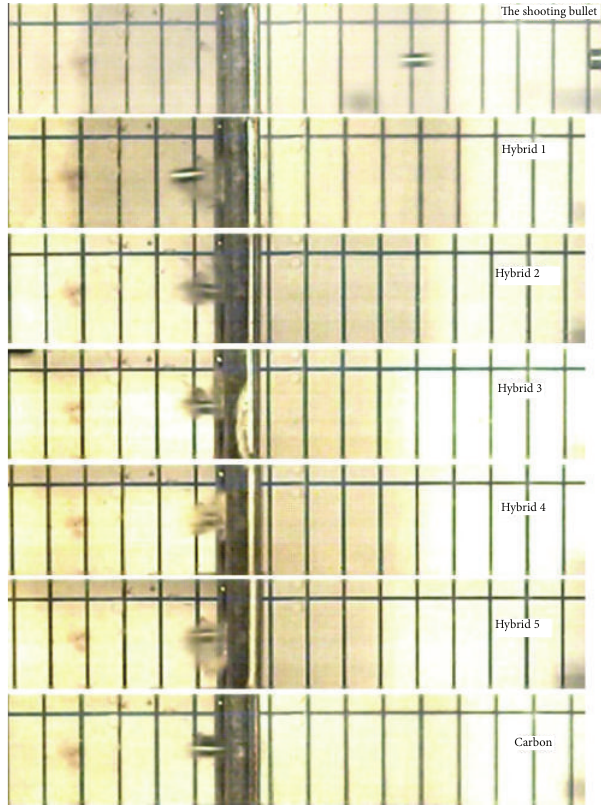
Figure 5: Process of penetration of pellet into the specimens [17, 18].